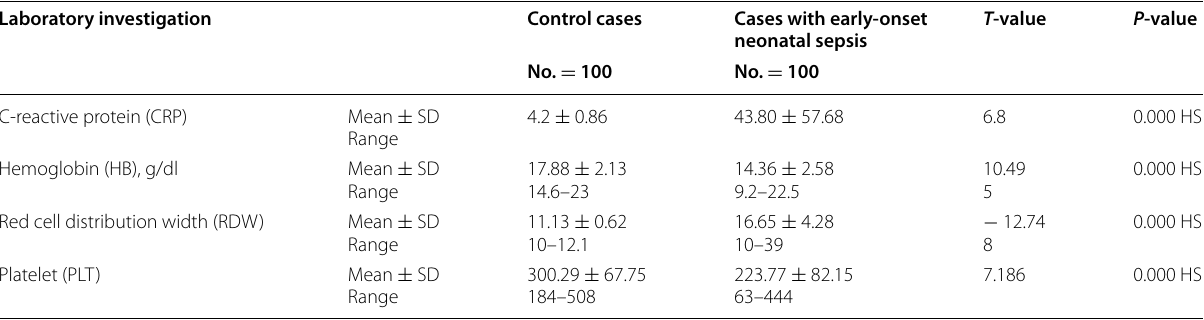
Table 2 Comparison between control cases (no. RDW, and